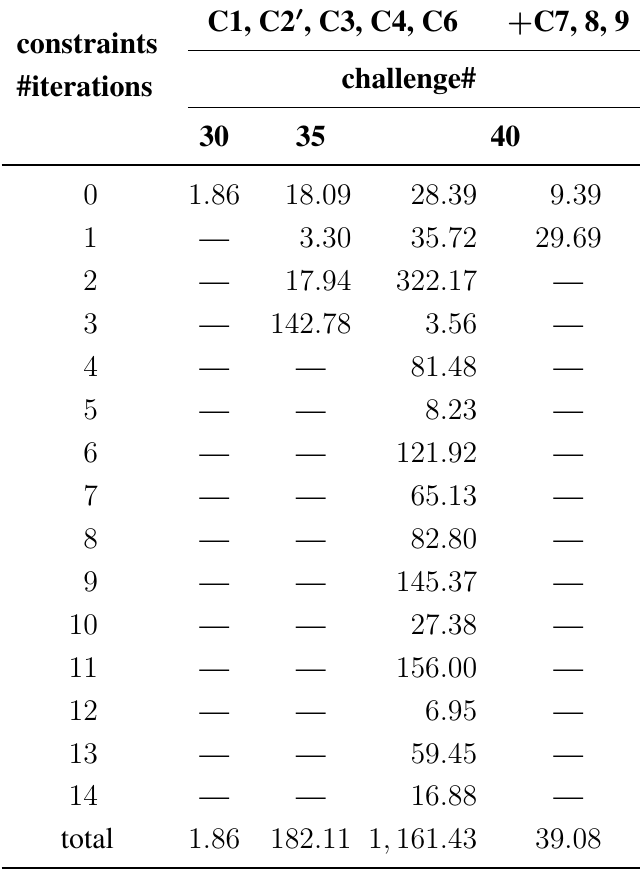
Table 4. Computational time (s) of solving IP formulations using C1, C2 ′ , C3, C4 and C6 for challenge numbers 30, 35 and 40; and IP formulations adding C7, C8 and C9 to them as well for challenge number 40 (rightmost